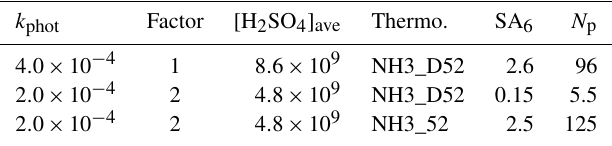
Table 1. Effect of doubling forward rate coefficients due to en- hanced van der Waals interactions on clusters in binary homoge- neous nucleation. The two thermodynamic schemes for binary con- ditions are plotted in the